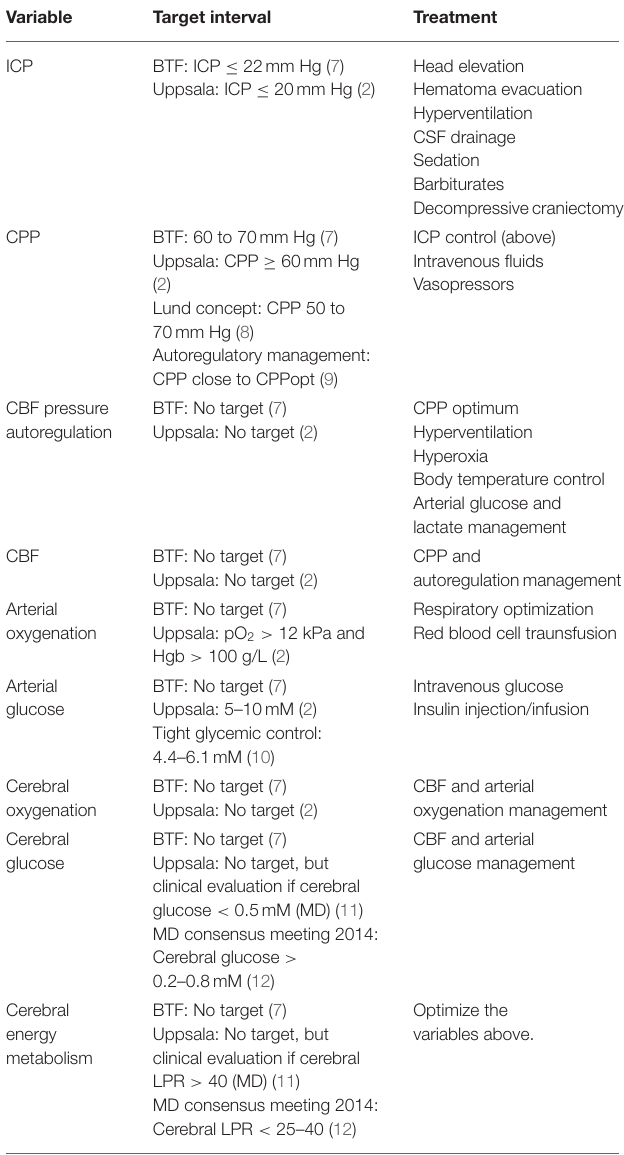
TABLE 2 | Monitoring variables, target intervals, and treatments. Variable Target